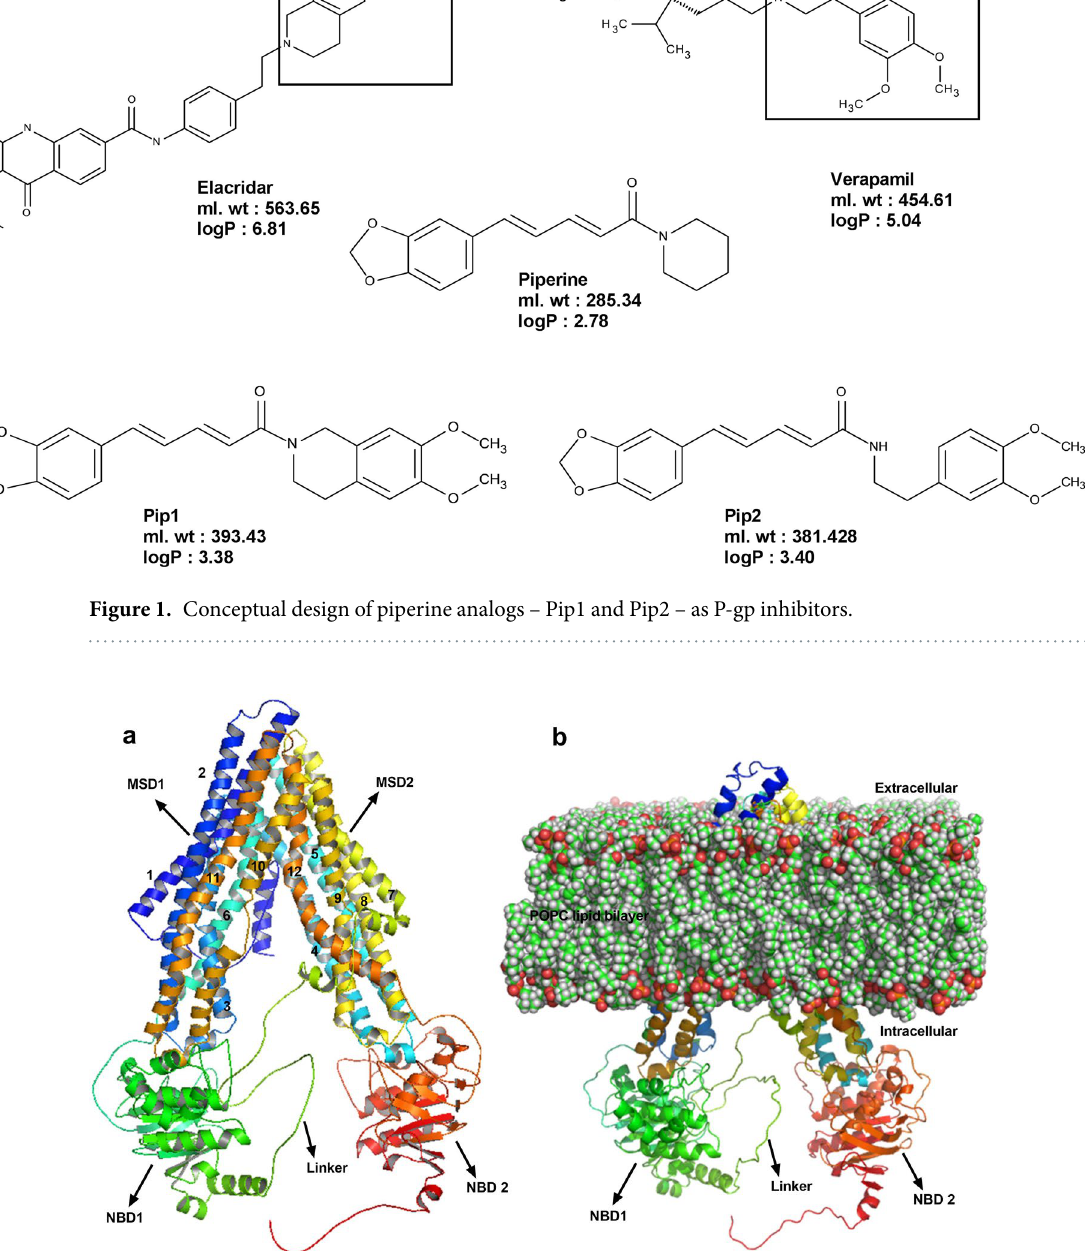
Ramachandran plot (supplementary result Fig. S2) of hP-gp homology model (Fig. 2a) showed 92.5% of residues (1064 amino acids) in the most favored region; 6.6% of residues (76 amino acids) in additional allowed region; 0.9% of residues in generously allowed region; and no residues in the disallowed region. The RMSD between tem- plate (PDB ID: 4F4C) and the modeled hP-gp was found to be 2.68 Å, suggesting that the modeled human P-gp protein had significant structural similarities with C. elegans P-gp. Based on the Ramachandran plot and RMSD